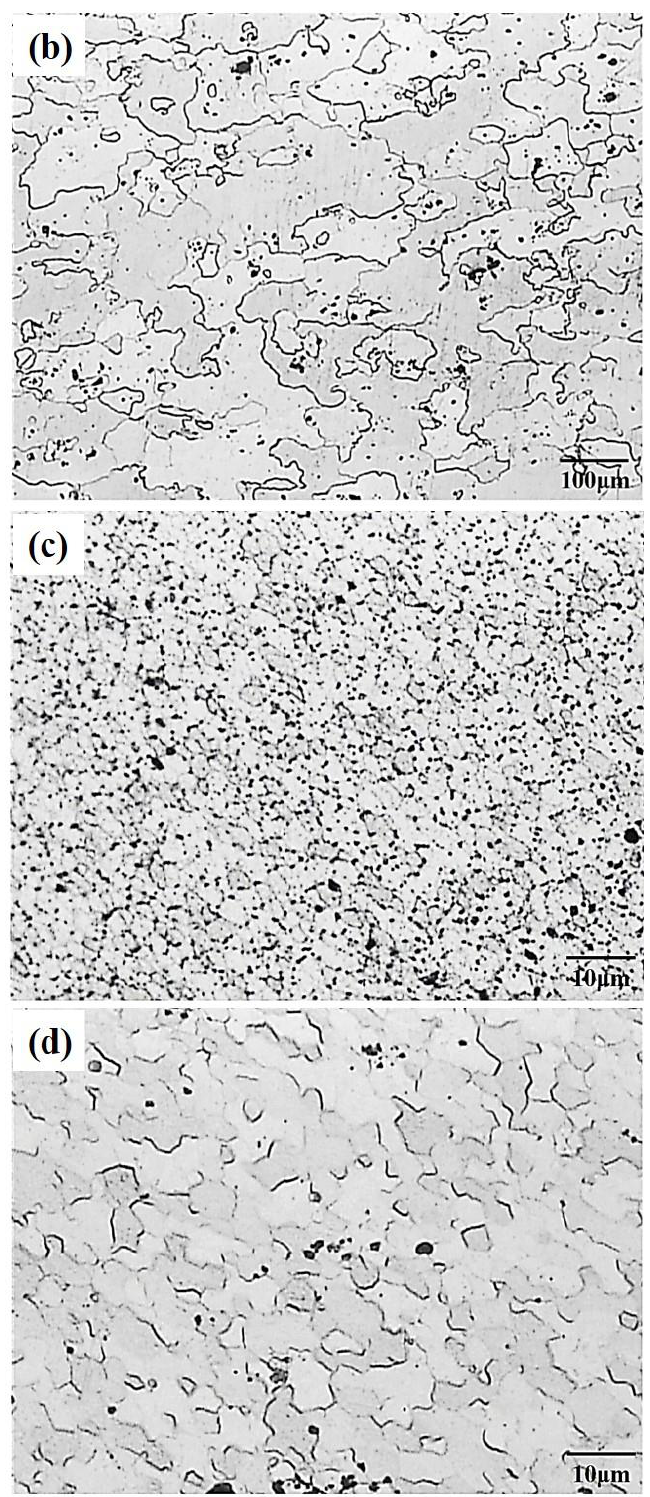
Figure 8. The microstructure of 7075 aluminum alloys after FSP and various heat treatments: ( a ) BM-O specimen, ( b ) BM-W specimen ( c ) 440-NA specimen, ( d ) 440-W specimen.